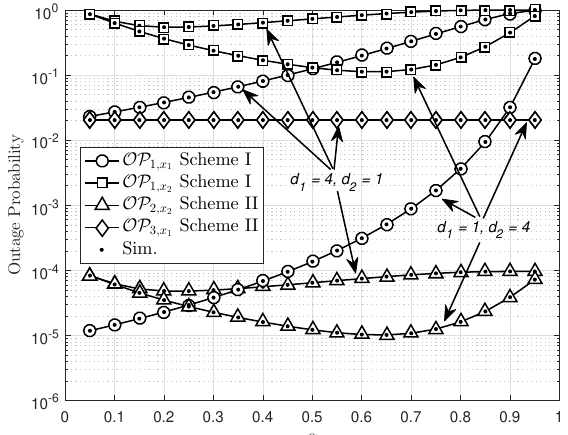
Figure 8. Outage probability versus the power-splitting ratio α with N S = 2, N D = 3, P S = 20 dB, a 1 = 0.2 and a 2 = 0.8.